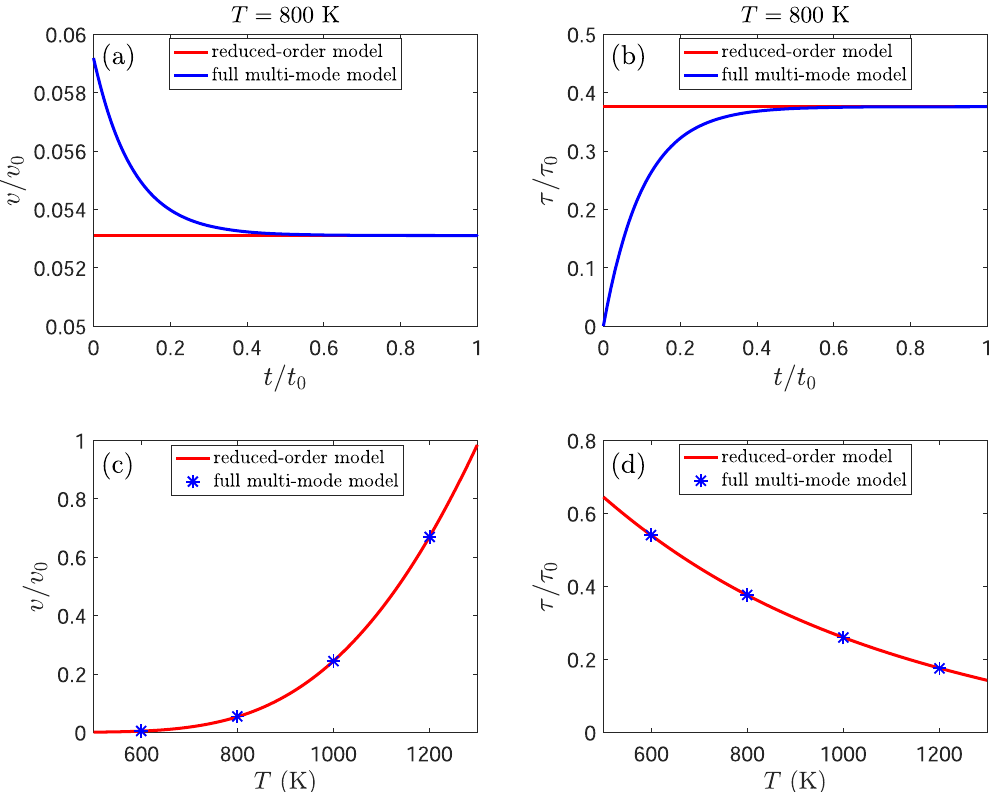
Fig. 3 Migration of a fl at GB. Migration of a nominally fl at, Σ 13[100](015) symmetric tilt GB in Cu driven by a chemical potential-jump across the GB of Ψ = − 1 meV ⋅ Å − 3 using the zero-shear, reduced-order model and the full multi-disconnection mode model 15 . The GB migration velocity in a and internal stress in b at T = 800 K predicted by the reduced-order model (red lines) and the full multi-disconnection mode model with fi xed boundary conditions (blue curves). The predicted steady state GB migration velocity in c and internal stress in d are shown as a function of T (blue points: full multi-disconnection mode model). Stress is normalised by τ 0 = − Ψ H (2) / b (2) , GB velocity by the T = 1300 K velocity v 0 , and t 0 = L 0 / v 0